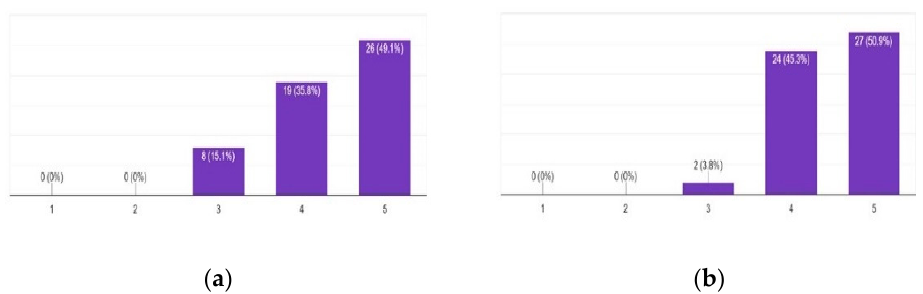
Figure 19. Participants’ opinion: ( a ) students’ involvement in the design and implementation stages increased their ability to compile unknown and innovative technologies; ( b ) students’ involvement increased their ability to document and communicate their work.